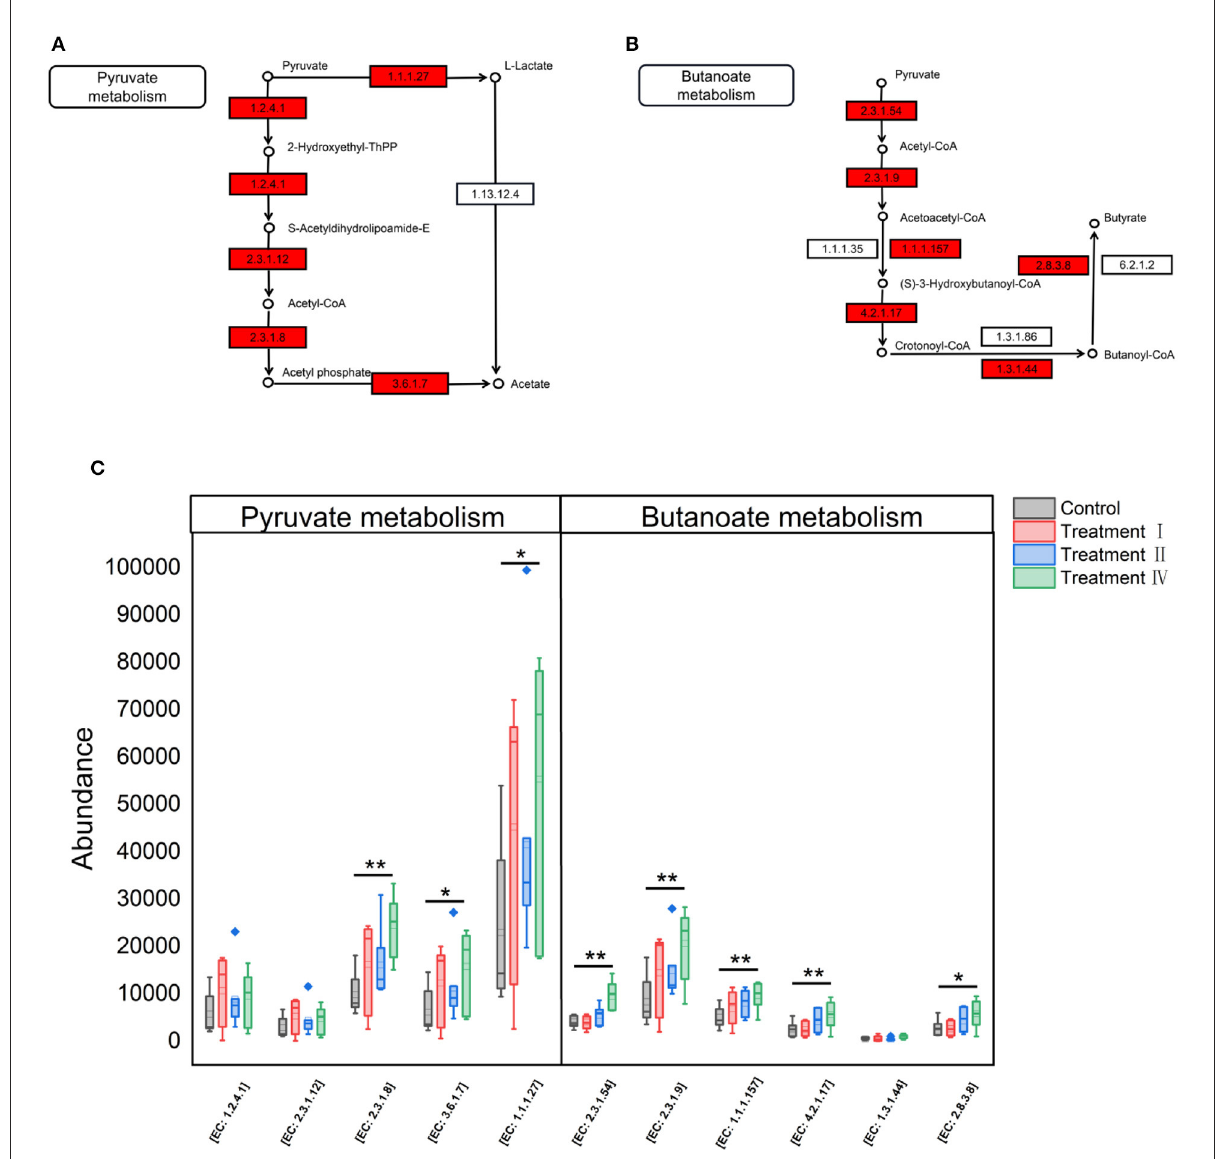
FIGURE8 KEGG pathways and enzymes of microbiota related to fiber degradation. (A) Enzymes related to acetate production in pyruvate metabolism. (B) Enzymes related to butyrate production in butanoate metabolism. The enzyme with red filling color is predicted by the special gene set in this study. (C) Variation of enzymes among four groups with the increasing of dietary fiber level. * P < 0.05, ** P <